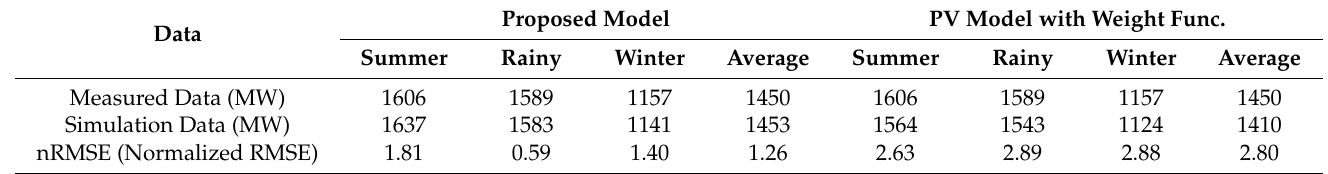
Table 9. Comparison of the proposed model and the PV Model with the weight function in 2019. Proposed Model PV Model with Weight Data